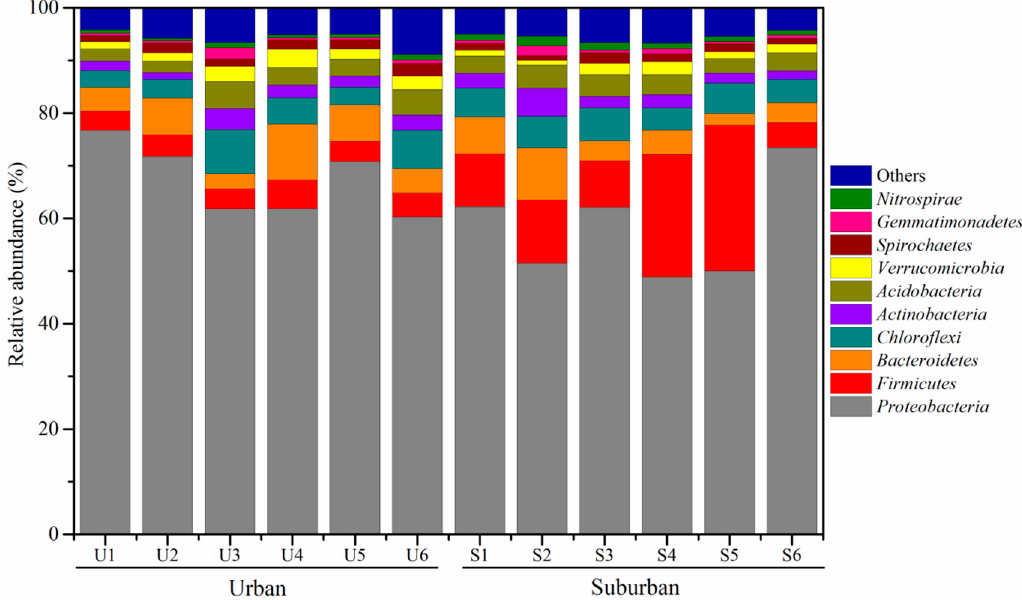
Figure 2. Relative abundance of sediment top 10 bacterial community compositions at phylum level. The relative abundance is expressed as the percentage of the targeted sequences to the total high-quality bacterial sequences of samples. “Others” refers to the taxa with a maximum abundance of < 1% in any sample.